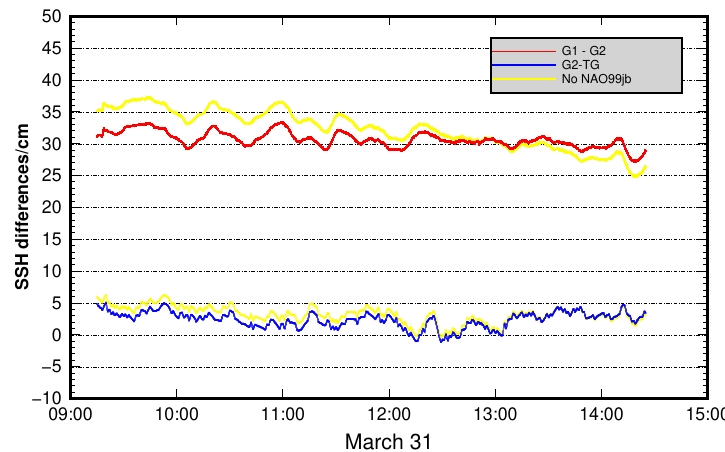
Figure 9. Sea surface height (SSH) difference between GNSS buoy 1 and buoy 2 (expressed as G1-G2), and the SSH difference between GNSS buoy2 and the tide gauge (expressed as G2-TG). The yellow lines represent the SSH differences without the correction of the NAO99jb tide